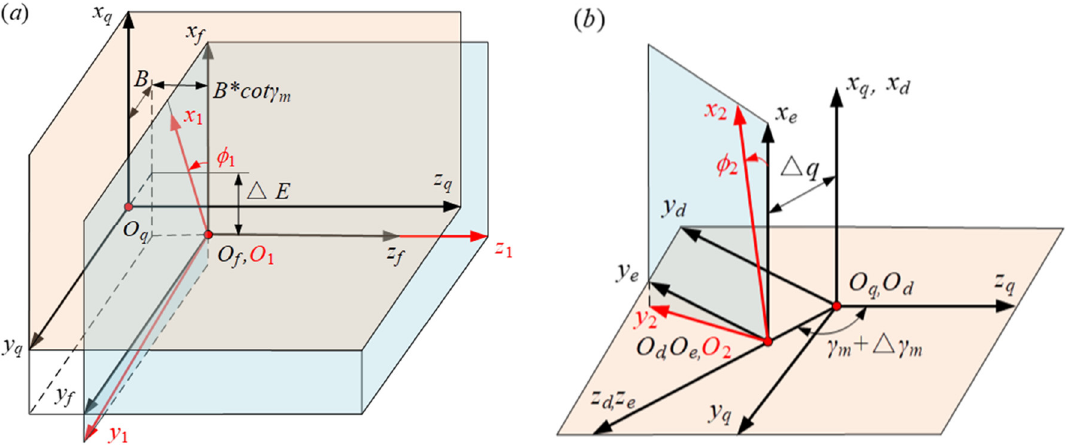
Figure 2. The coordinate system with assembly errors in ETCA: ( a ) the coordinate system with Δ E ; ( b ) the coordinate system with Δ q and Δ γ m .